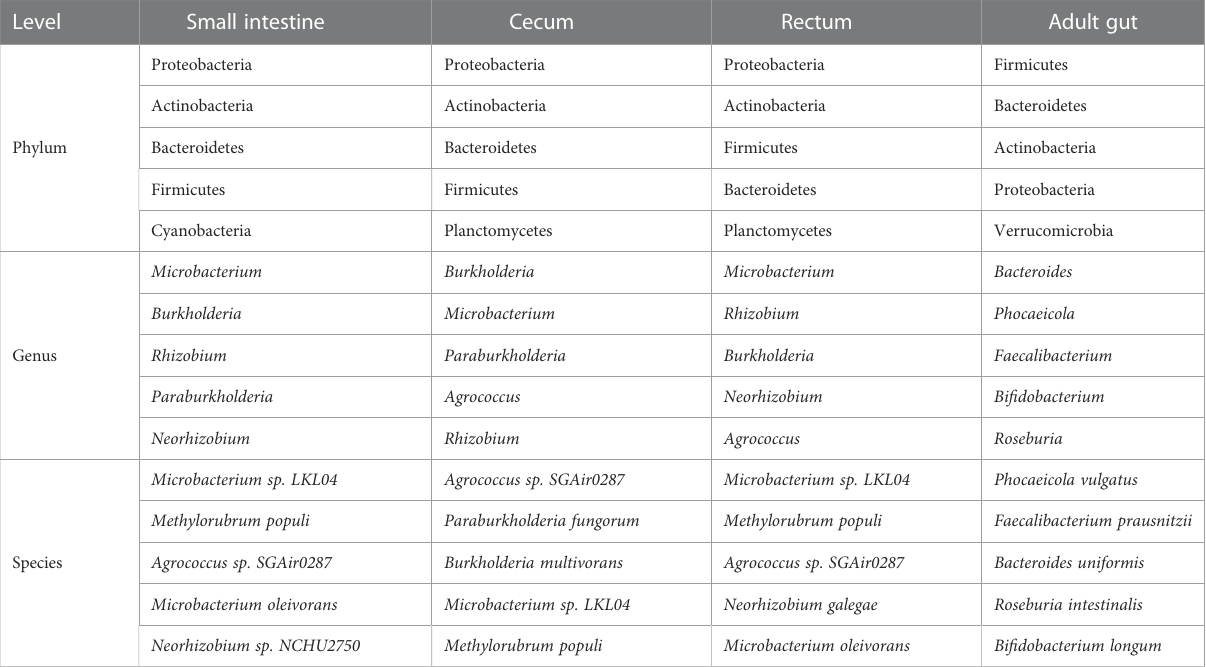
TABLE 1 Top 5 bacteria at phylum, genus and species level